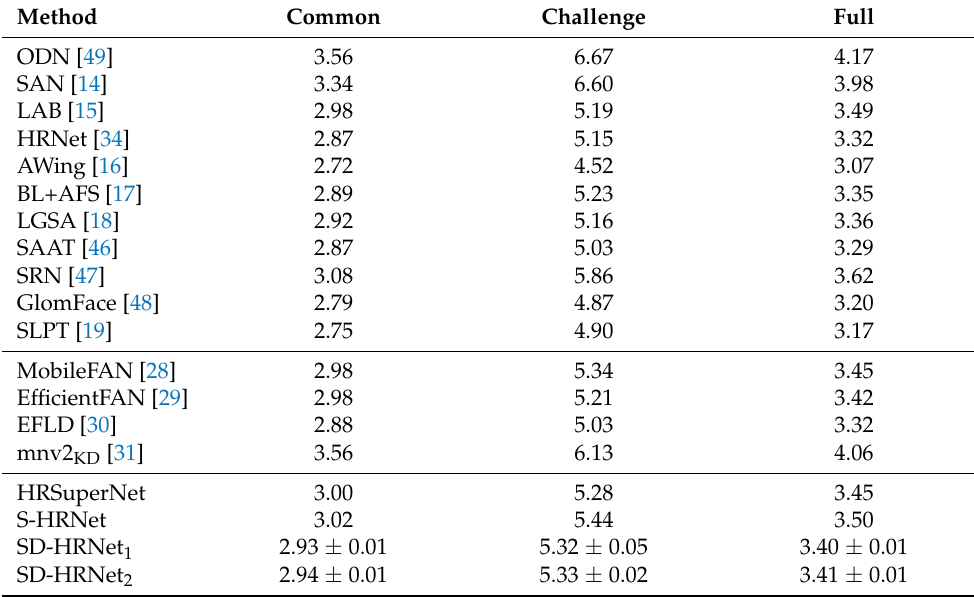
Table 2. Comparison of NME (%) on 300W: common subset, challenge subset, and full set. Method